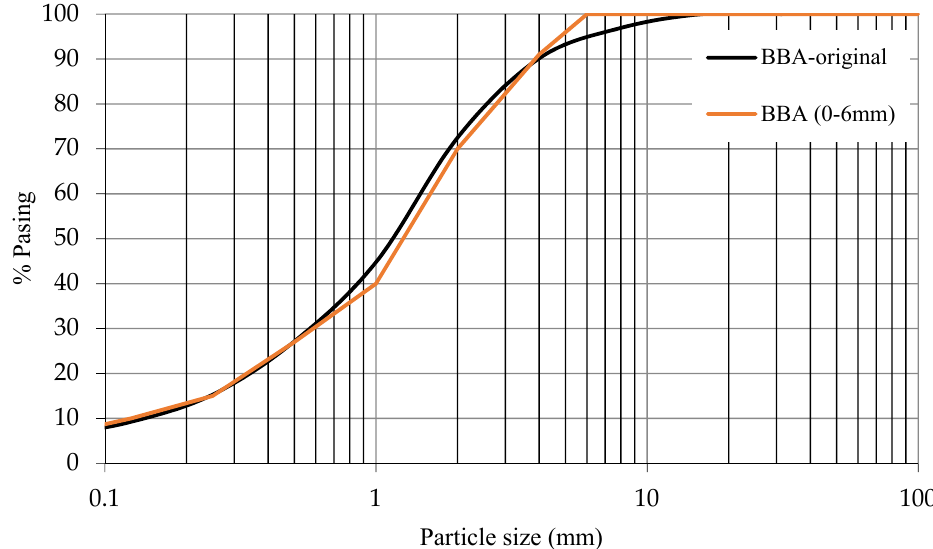
Figure 2. Particle size distribution curve of BBA original and BBA (0–6 mm).